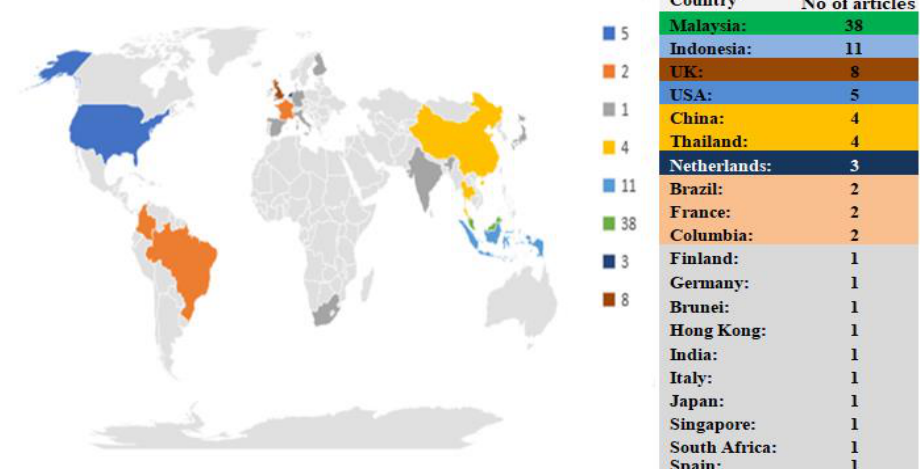
Figure 6. Geographical distribution of reviewed articles.